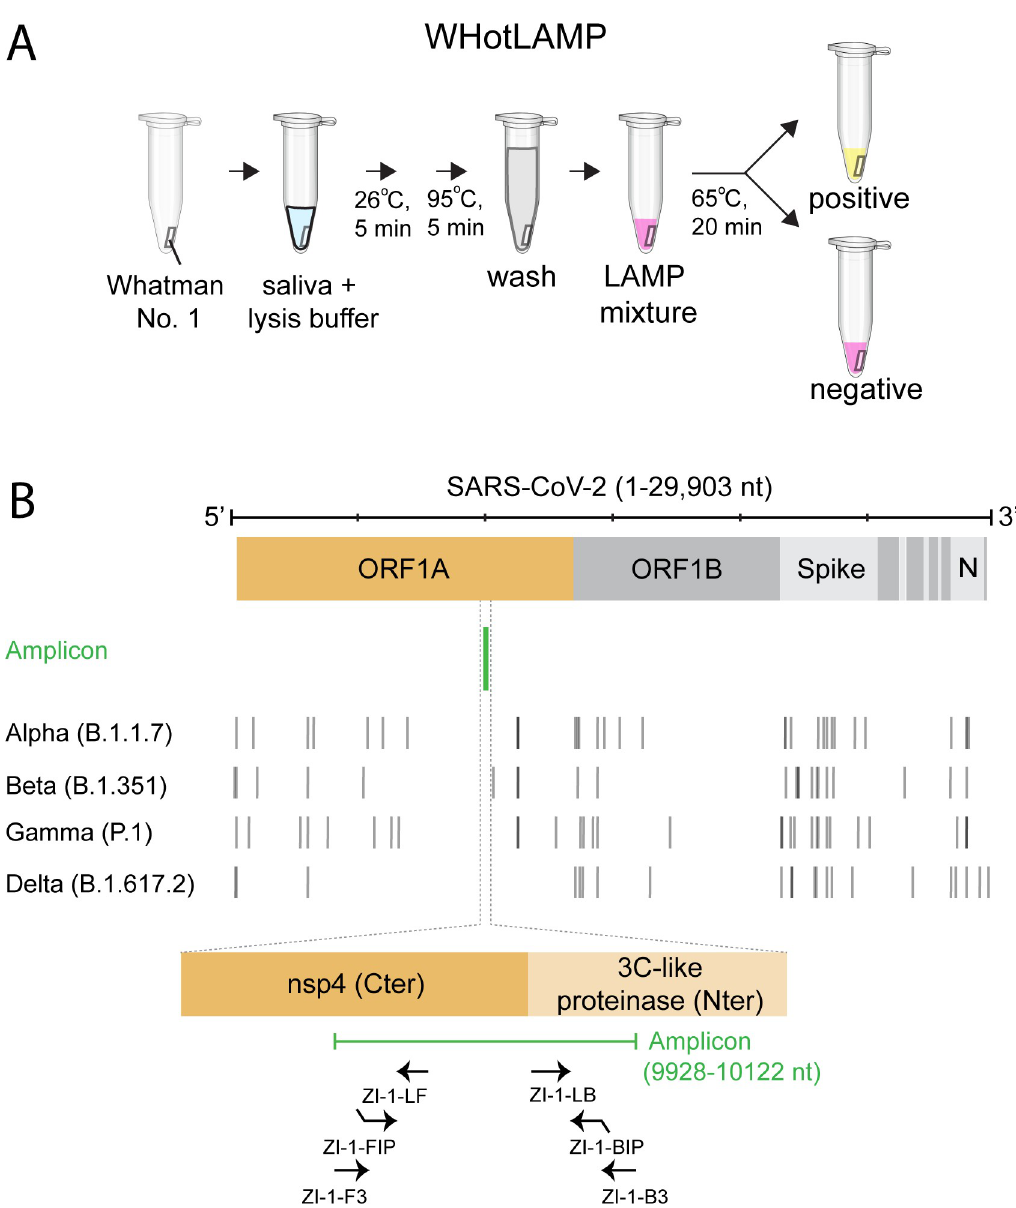
Fig 2. Overview of WHotLAMP assay and primers. A . Schematic of the WHotLAMP assay. B . Location of ZI-1 LAMP primers and amplicon relative to mutations (vertical lines) defining SARS-CoV-2 variants. high levels in multiple tissues [44]. RAB7A LAMP primers led to a yellow color change with saliva from healthy donors, but not when RNase A was added after Proteinase K treatment, indicating the amplification originated from RNA and not genomic DNA (Fig 4A and 4B). In contrast, the reaction control (RPP30) in the CDC-recommended RT-qPCR test panel for SARS-CoV-2 amplifies both genomic DNA as well as cDNA [45]. Further testing of additional saliva samples with RAB7A LAMP led to a yellow color change in 20 of 20 individual samples, indicating that the RAB7A LAMP primers are an appropriate control for benchmarking suc- cessful RNA extractions from saliva.